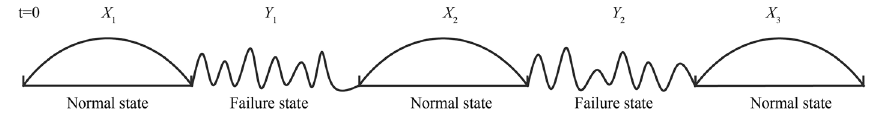
Figure 1. Ventilation system’s operational process (repairable system).